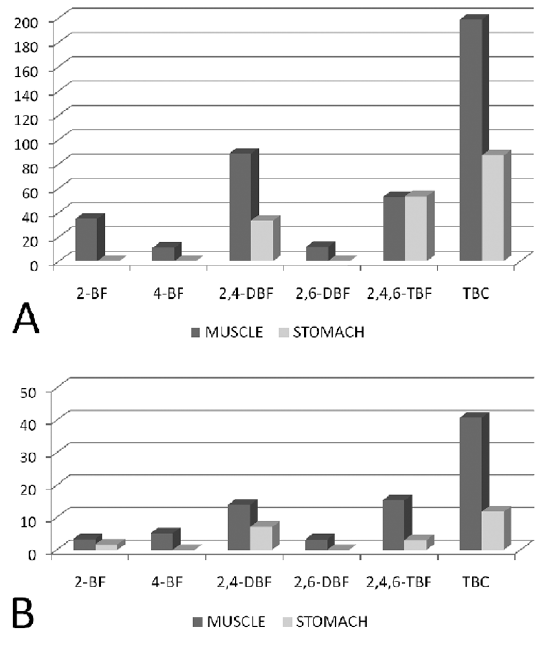
Fig. 2 – Bromophenol concentrations and TBCs in the muscle and stomach of L. synagris collected in winter (A) and summer time (B).